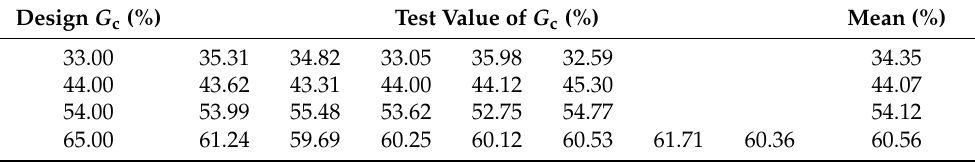
Table 6. V V values of the combined-material specimens determined by burn-off tests. Design G c Table 3. G c values of the single-material specimens determined by burn-off tests.